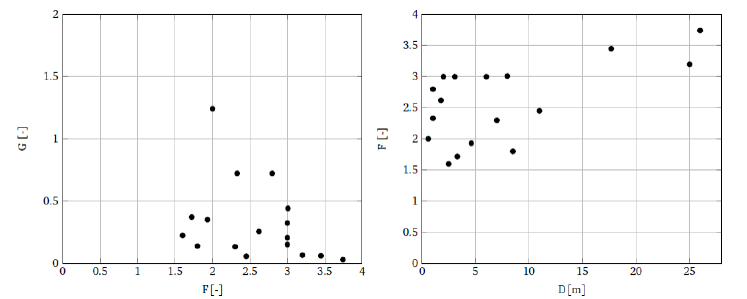
Figure 9. ( left ): G = f ( F ) , k = ( 1 + β ) /3, C T